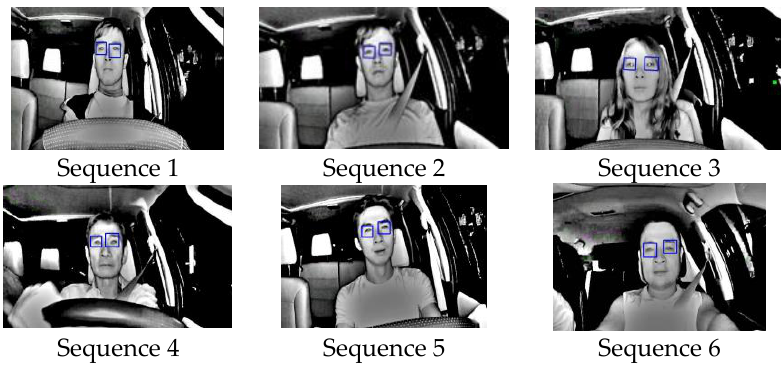
Figure 22. Six Test Video Sequences for Driver Drowsiness. Table 5. Results of Detecting Eyes Closed.